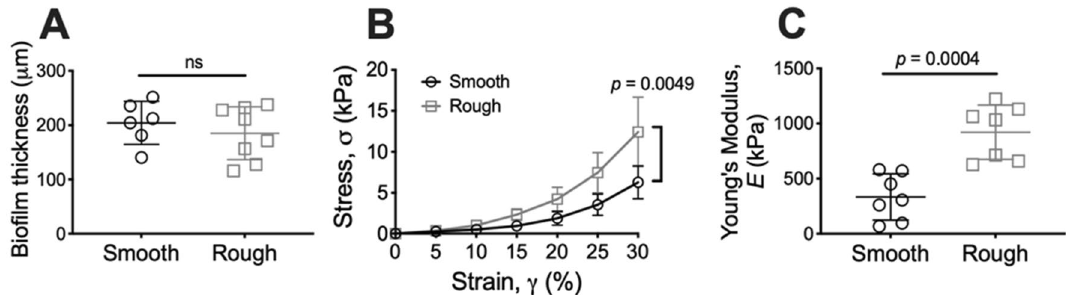
Figure 2. Ma Rg colony-biofilms are stiffer compared to Ma Sm biofilms in compression. (A) Thickness and (B) stress–strain curves of 4 day M . abscessus colony-biofilms determined from uniaxial indentation analysis. (C) Young’s modulus of M. abscessus biofilms, determined from the lower linear potion of the force–displacement curve, corresponding to 0–30% strain. The full stress–strain curve, up to 100% strain is represented in Fig. S1. N = 4; data presented as individual data points with mean ± SD. Statistical analysis was performed using a Student’s t-test; ns indicates not significant.